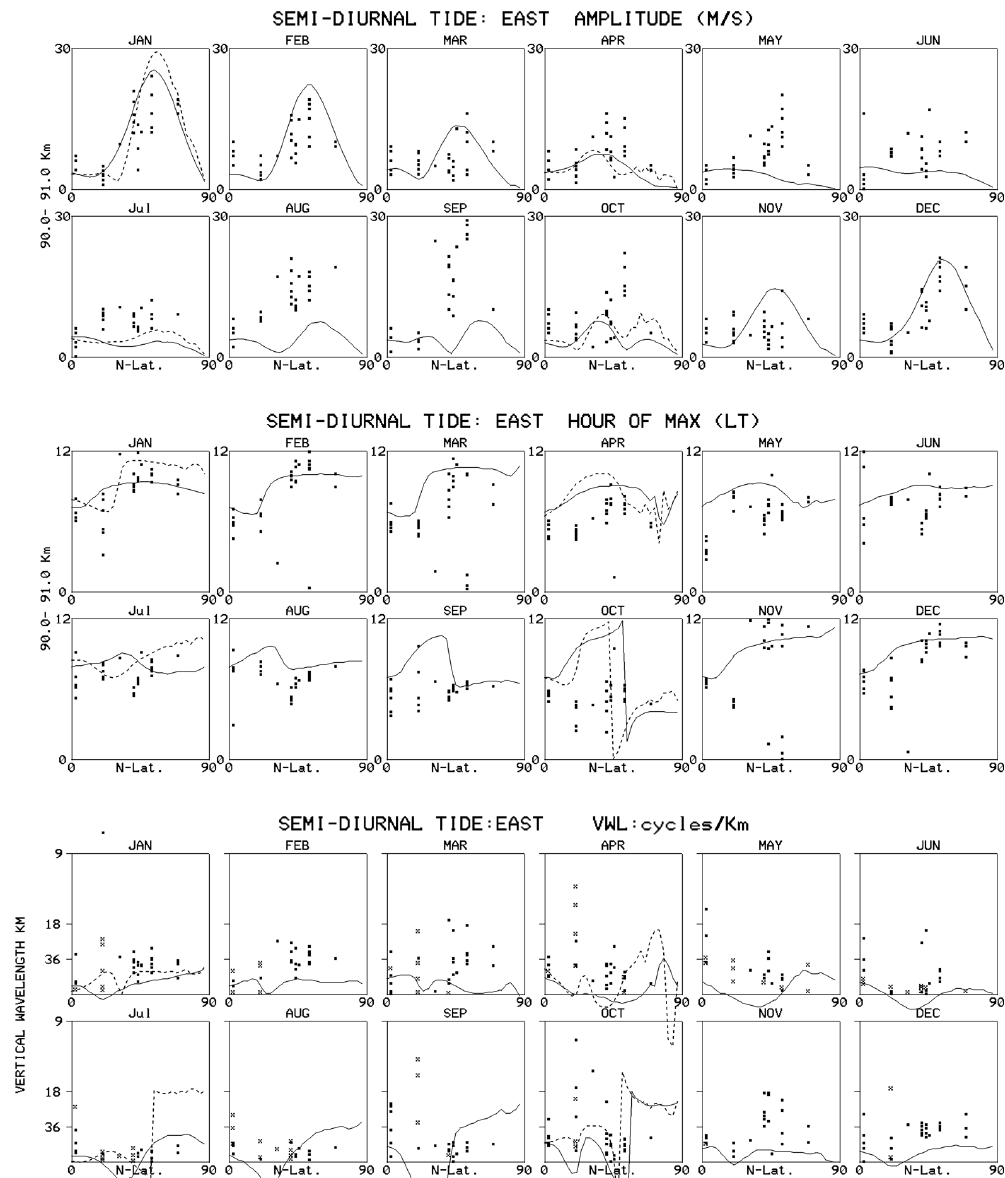
Fig. 3. Latitudinal plots for the zonal (East) component of the Semi-Diurnal (12h) Tide near 90km. The dots are for all of the available years at the MFR locations; these now include Christmas Island 2 ◦ N, Hawaii 22 ◦ N, Yamagawa 31 ◦ N, Urbana 40 ◦ N, London 43 ◦ N, Wakkanai 45 ◦ N, Saskatoon 52 ◦ N, Tromsø 70 ◦ N. As before, the solid lines are for GSWM and the dashed for GSWM2000. The phase-gradients, interpreted here as vertical wavelengths, are over 6km centred on